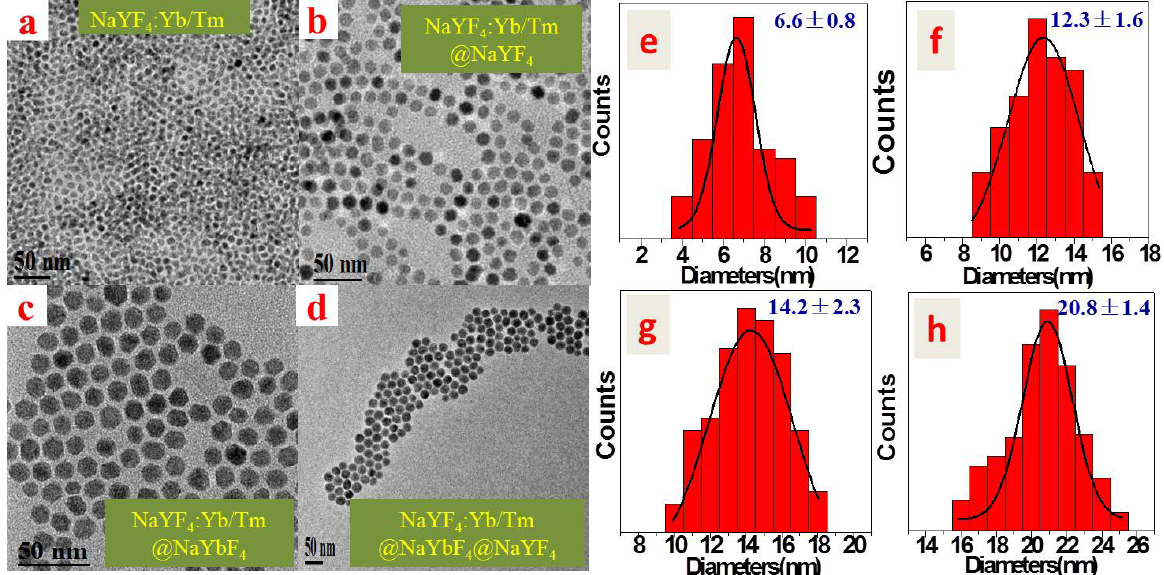
Figure 1. Transmission electron images (TEM) of: ( a ) The core NaYF : 30%Yb 3+ , 4 : 30%Yb 3+ , 0.5%Tm 3+ nanoparticles; ( b ) The active core/inert shell (NaYF 4 0.5%Tm 3+ )/NaYF nanoparticles; ( c ) The active core/active shell (NaYF : 30%Yb 3+ , 4 4 0.5%Tm 3+ )/NaYbF nanoparticles; and ( d ) The active core/active shell/inert shell (NaYF : 4 4 /NaYF nanoparticles. Histogram of size distribution of 30%Yb 3+ , 0.5%Tm 3+ )/NaYbF 4 4 ( e ) The core NaYF : 30%Yb 3+ , 0.5%Tm 3+ nanoparticles; ( f ) The active core/inert shell 4 (NaYF : 30%Yb 3+ , 0.5%Tm 3+ )/NaYF nanoparticles; ( g ) The active core/active shell 4 4 : 30%Yb 3+ , 0.5%Tm 3+ )/NaYbF nanoparticles; and ( h ) The active core/active (NaYF 4 4 shell/inert shell (NaYF : 30%Yb 3+ , 0.5%Tm 3+ )/NaYbF /NaYF nanoparticles. The size was 4 4 4 evaluated according to TEM images of corresponding nanoparticles dispersed in hexane at a concentration of 0.1